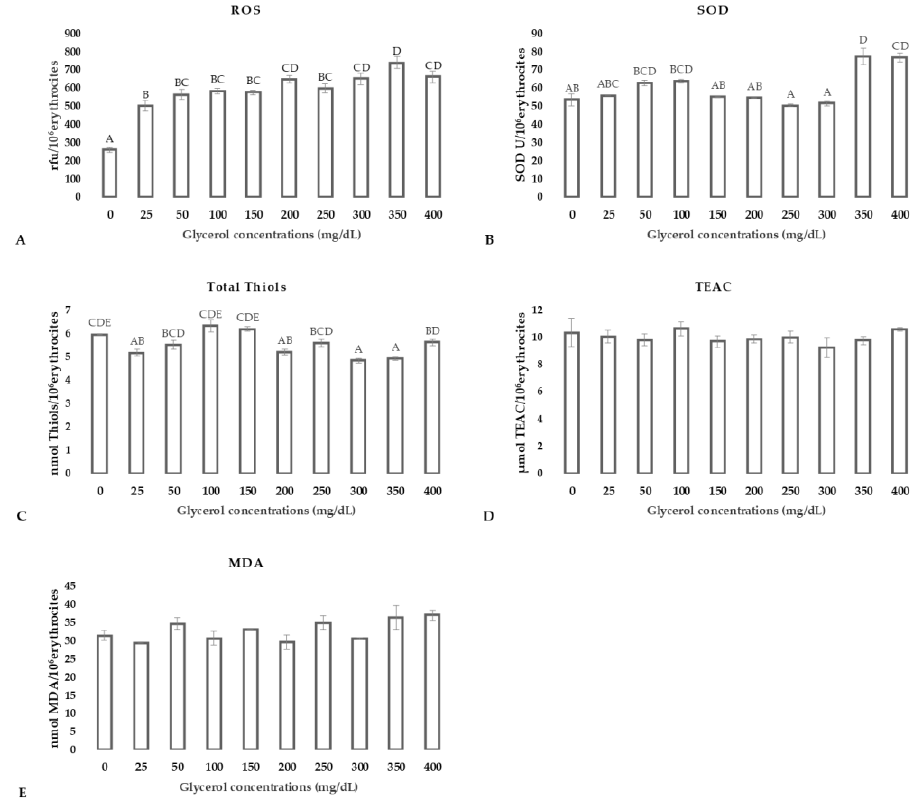
Figure 3. ROS production ( panel A ), SOD activity ( panel B ), total thiol concentrations ( panel C ), total anti-oxidant capacity (TEAC; panel D ), and MDA ( panel E ) concentration in RBCs after incubation in media supplemented with glycerol in concentrations ranging from 0 to 400 mg/dL. Uppercase letters indicate significant differences between groups: ROS p < 0.01; TEAC p = 0.764; total thiols p < 0.05; SOD p < 0.05; MDA p = 0.062 (one-way ANOVA–Tukey post hoc test).